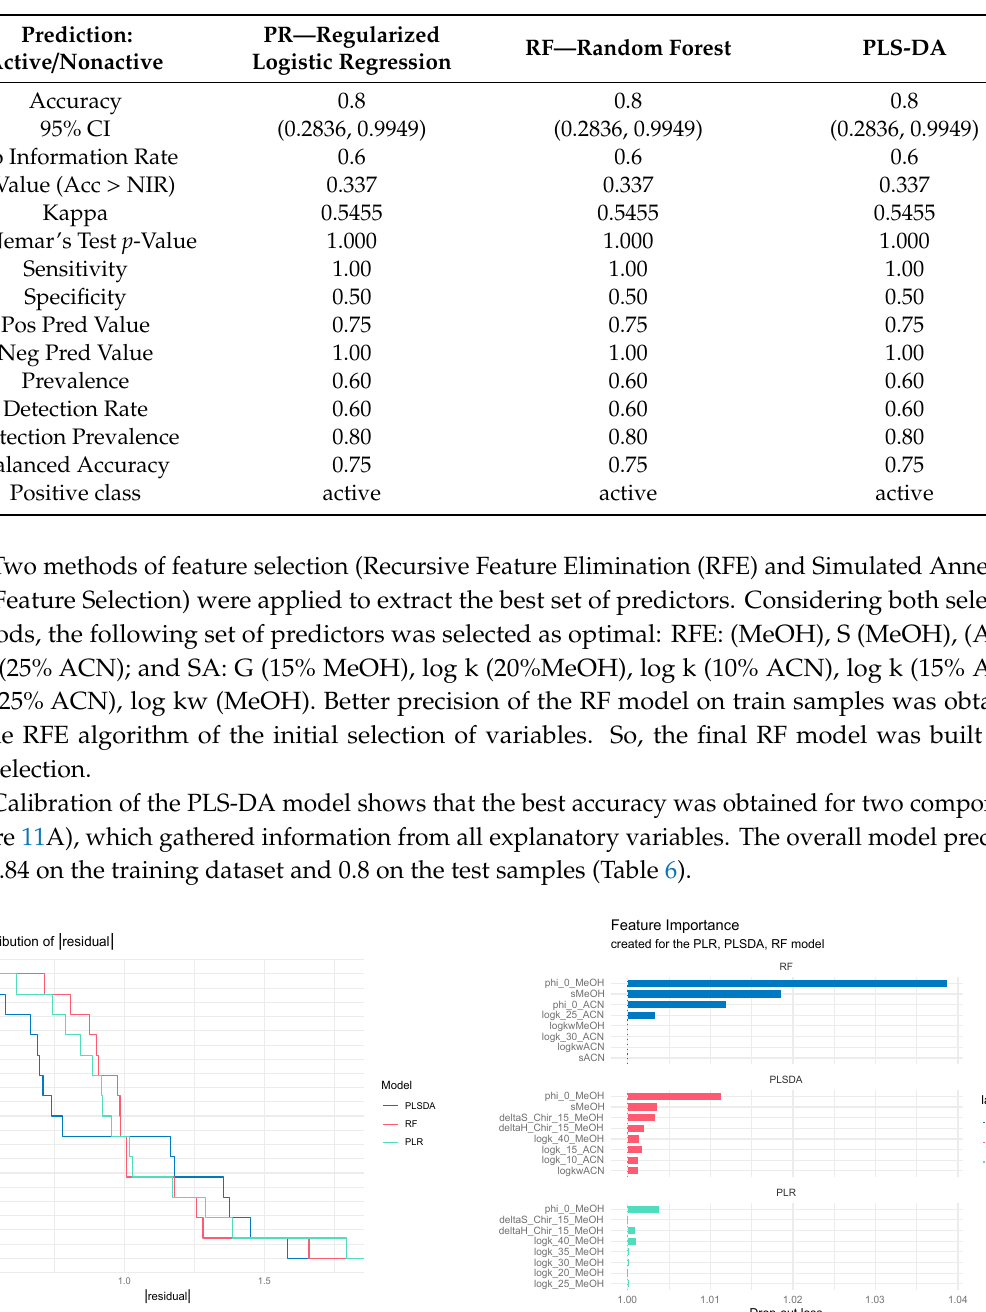
Table 6. Metrics for classification of PR, RF and PLS-DA on test data.